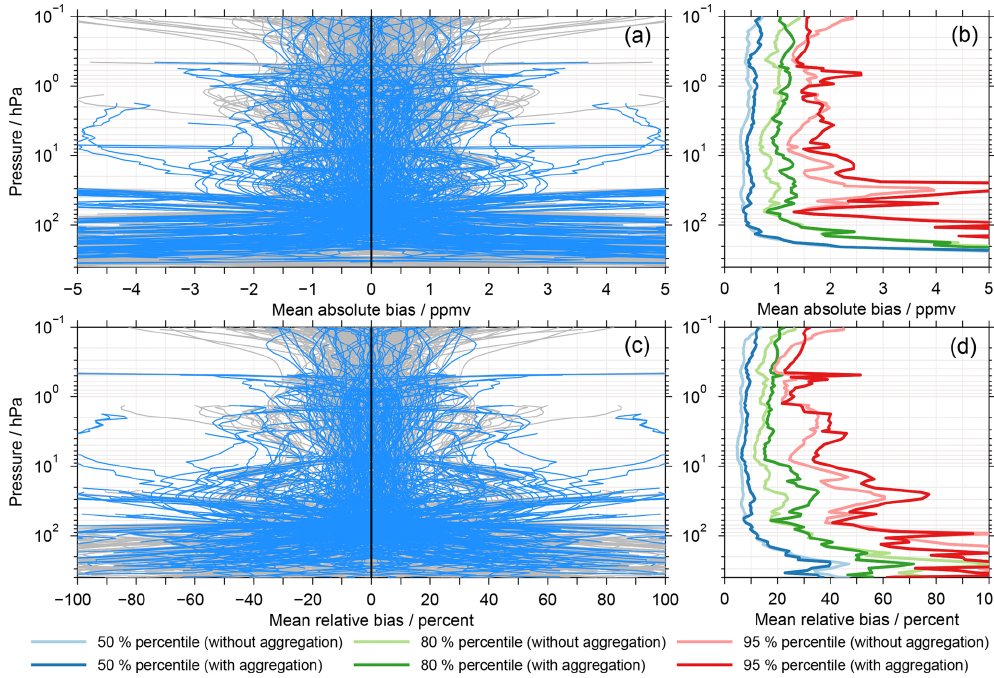
Figure 5. (a, c) Bias results for the full matrix of comparisons considering coincidences during all seasons and at all latitudes. Panel (a) shows the absolute biases; panel (c) shows the relative biases. The grey profiles do not consider the aggregation of the MIPAS results, while the light blue profiles do. (b, d) The 50% (median), 80% and 95% percentiles derived from the positive part of the biases shown in (a, c) , with and without the aggregation of the MIPAS